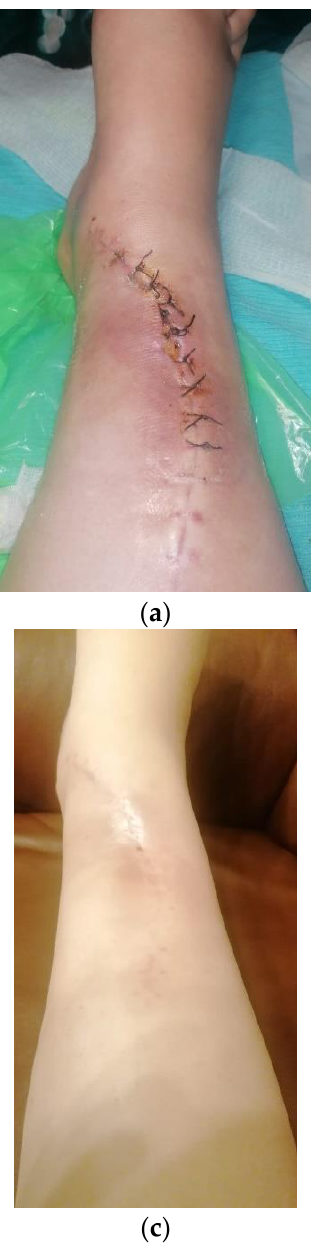
Figure 11. Skin dehiscence evolution: ( a ) Primary dehiscence; ( b ) Per secundam suture; ( c ) Healed wound.